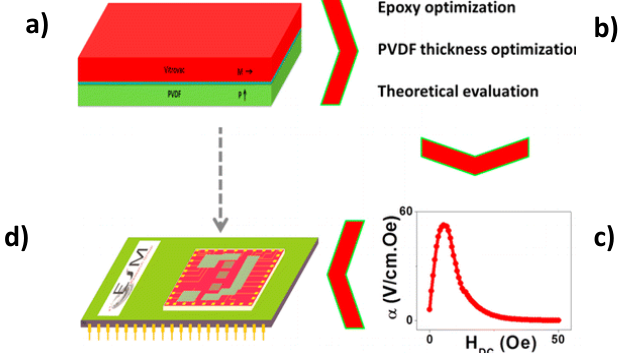
Figure 12. The schematic representation of the Vitrovac / Epoxy / PVDF composite ( a ); optimization process ( b ) and ME response ( c ) pave the way for its incorporation into technological applications such as magnetic sensors ( d ). Reproduced with permission from [82] .